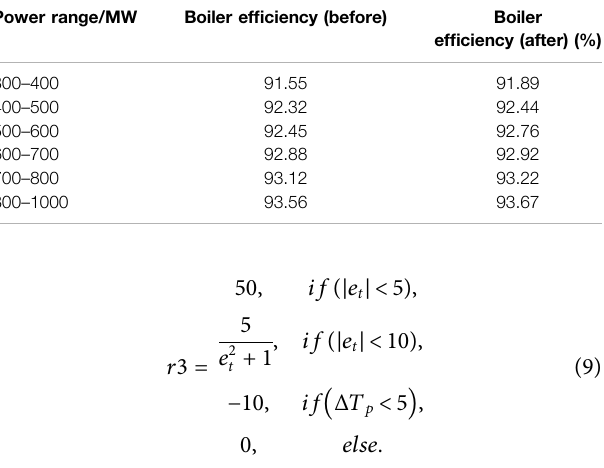
TABLE 2 | Comparison of the boiler ef fi ciency before and after